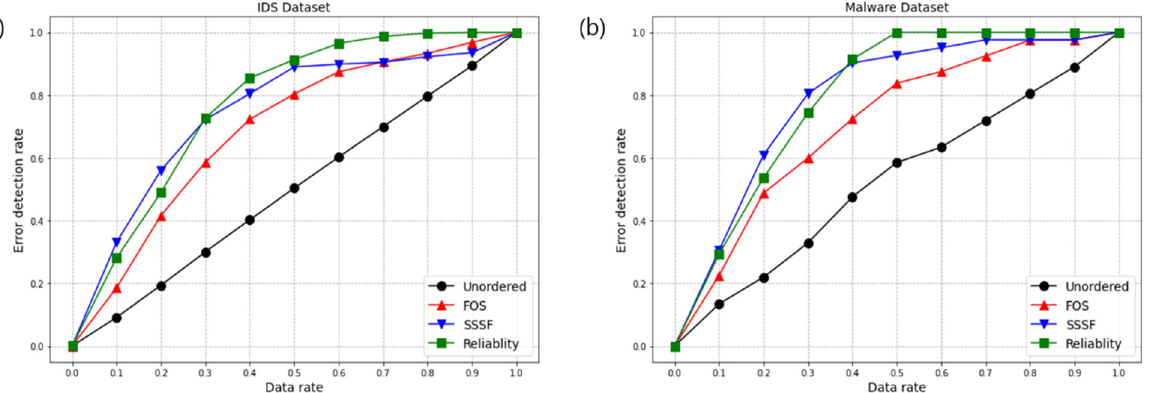
Figure 11. The number of errors detected by the AI model and the proposed method (IDS and mal- ware datasets) [25].